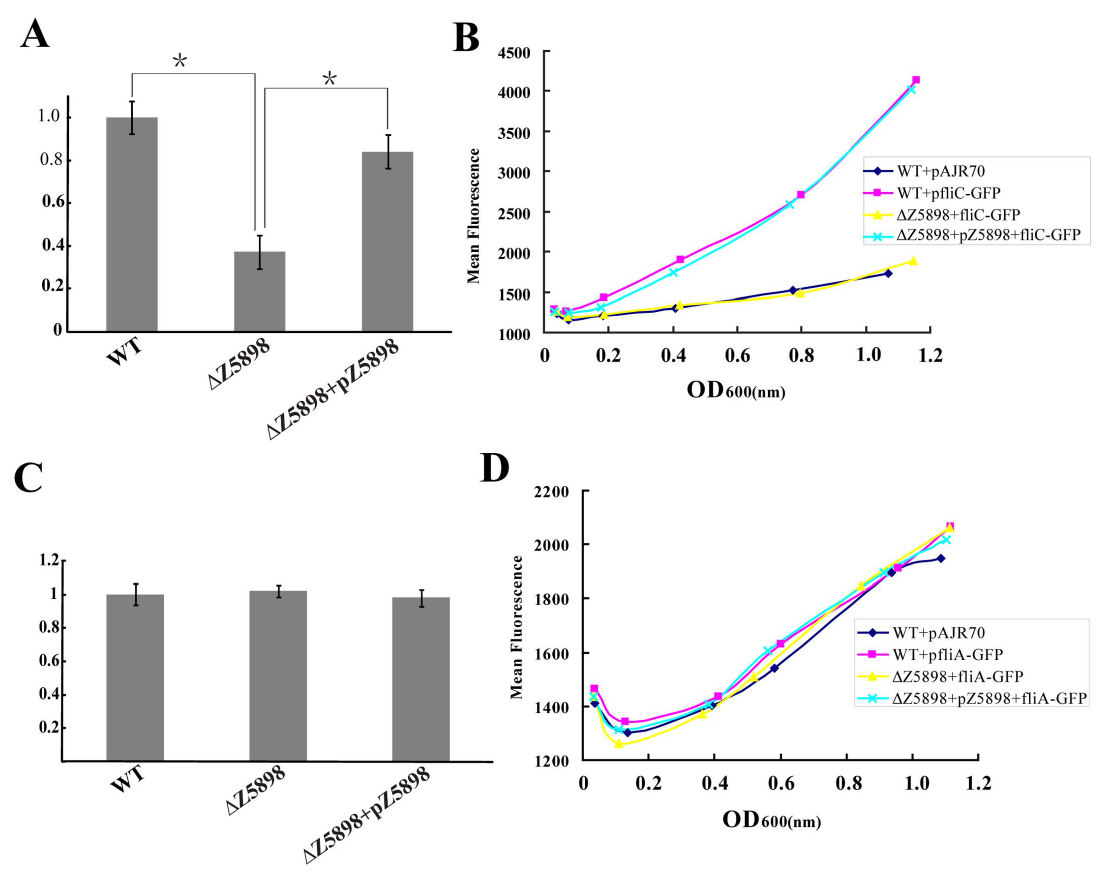
Figure 5. Transcriptional studies of fliC and fliA . (A) Expression of the fliC gene assessed at the mRNA level by quantitative reverse transcription PCR. Relative mRNA expression of fliC was normalized to that of the housekeeping gene gapA . Results represent mean values standard deviations (SD) for three independent experiments. Differences were analyzed for significance using T-test with significant difference between two strains (P , 0.01) indicated by a * with a linked line. (B) Measurements of the fliC promoter activity in EDL933, isogenic Z5898 deletion mutant and complemented strain. A 340 bp fliC promoter fragment was cloned into the promoter-less green fluorescence protein (GFP) plasmid pAJR70 to create transcriptional fusion plasmid pAJRfliC. The fluorescence produced by each strain and corresponding OD 600 was measured every 60 minutes. Fluorescence data were plotted against the mean OD 600 measurement. The promoter-less plasmid pAJR70 was used as control. WT, wild-type EDL933; D Z5898, Z5898 deletion mutant. (C) Expression of the fliA gene by qRT-PCR. Data was also normalized using gapA expression as in A. Error bar shows the standard deviation from three independent experiments. (D) Measurements of the fliA promoter activity in EDL933, isogenic Z5898 deletion mutant and complemented strain. A 464 bp fliA promoter fragment was cloned into the promoter-less green fluorescence protein (GFP) plasmid pAJR70 to create transcriptional fusion plasmid pAJRfliA. doi:10.1371/journal.pone.0064211.g005 and involves in crucial initiating step for colonization [48]. The H7 flagellin has a role in provoking mucosal inflammation. It activates MAP kinase signalling pathways and the transcription factor NF- kB, leading to secretion of proinflammatory chemokines by human intestinal epithelial cells [49,50]. Thus additional control of the flagellar synthesis instigated by Z0021 and Z5898 encoded on the O157:H7 specific OI-1 and OI-172 which represses and activates flagella expression respectively may enhance the role of flagella in the pathogenesis of O157:H7. Timing of the flagella expression may affect virulence. Turning it on during early stages of infection may aid colonisation while turning it off helps immune evasion once infection is established. In Salmonella , a recent study showed that an overexpression of either FliC or FlhDC alone, and co- expression of the two, significantly attenuates Salmonella virulence [51]. However further studies are required to determine the precise mechanisms and the timing of the control by both Z0021 and Z5898 and their regulatory roles in flagella synthesis in vivo .